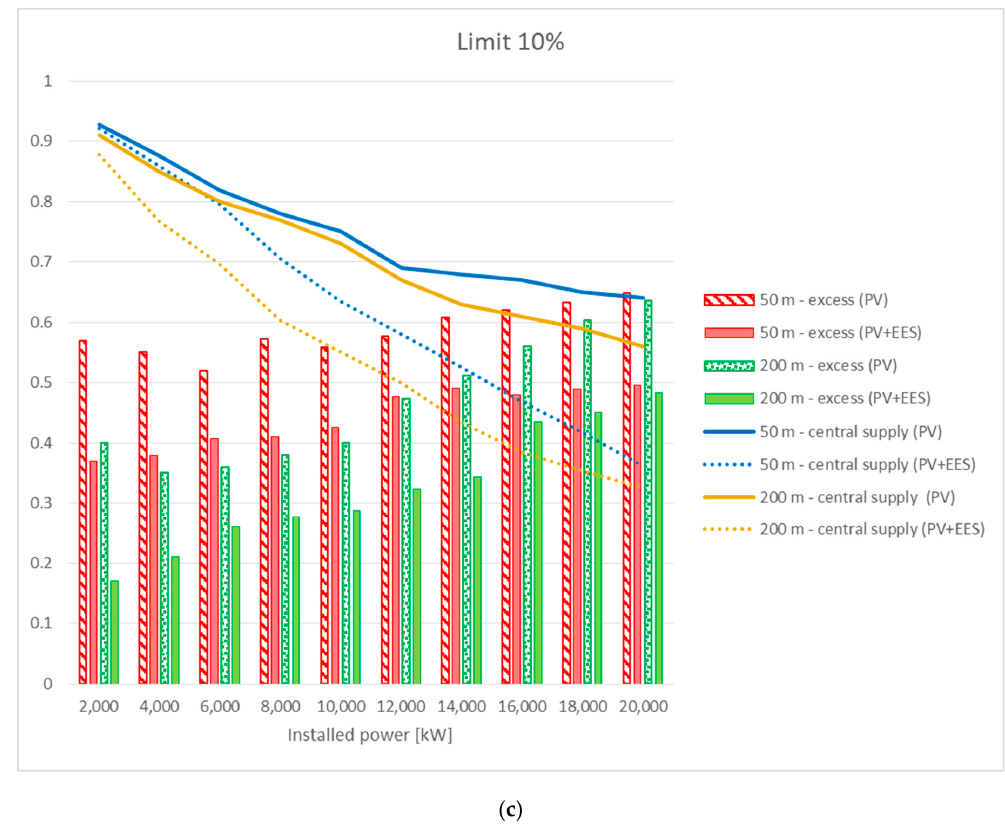
Figure 9. The excess and the central supply in both scenarios at di ff erent radius and when varying the Figure 9. The 𝑒𝑥𝑐𝑒𝑠𝑠 and the 𝑐𝑒𝑛𝑡𝑟𝑎𝑙 𝑠𝑢𝑝𝑝𝑙𝑦 in both scenarios at different radius and when installed capacity on the urban territory when ( a ) limit = 0%; ( b ) limit = 5% and ( c ) limit = 10%. varying the installed capacity on the urban territory when ( a ) limit = 0% ; ( b ) limit = 5% and ( c ) limit = 10%